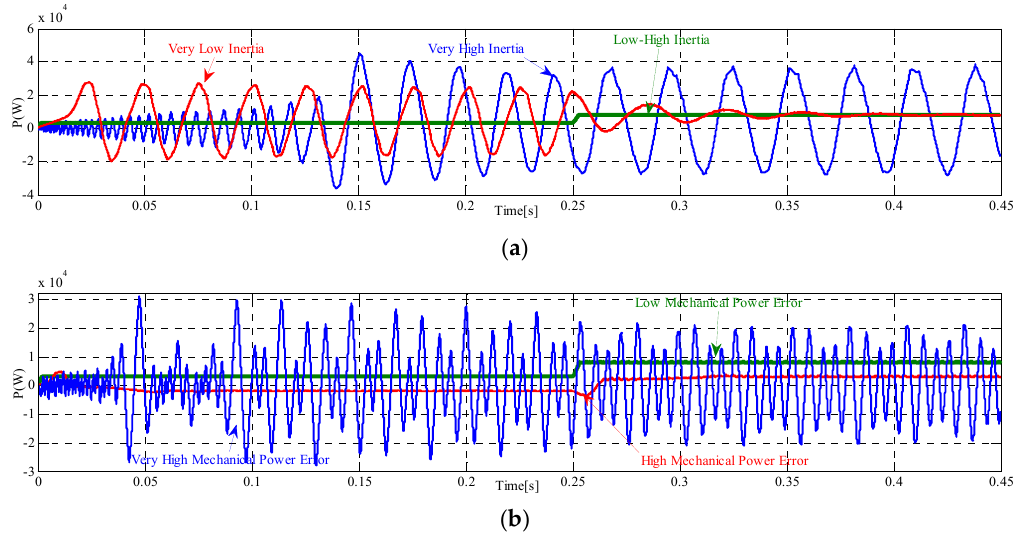
Figure 9. Active power of the proposed controller-based converter under: ( a ) various inertia values, and ( b ) various VMPE values.